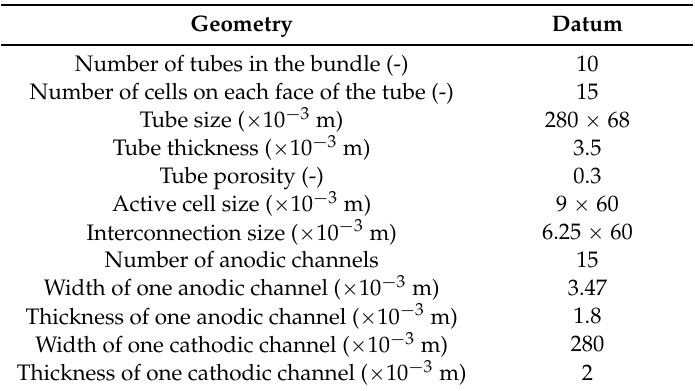
Table 1. Geometrical details of the IP-SOFC planar tube and